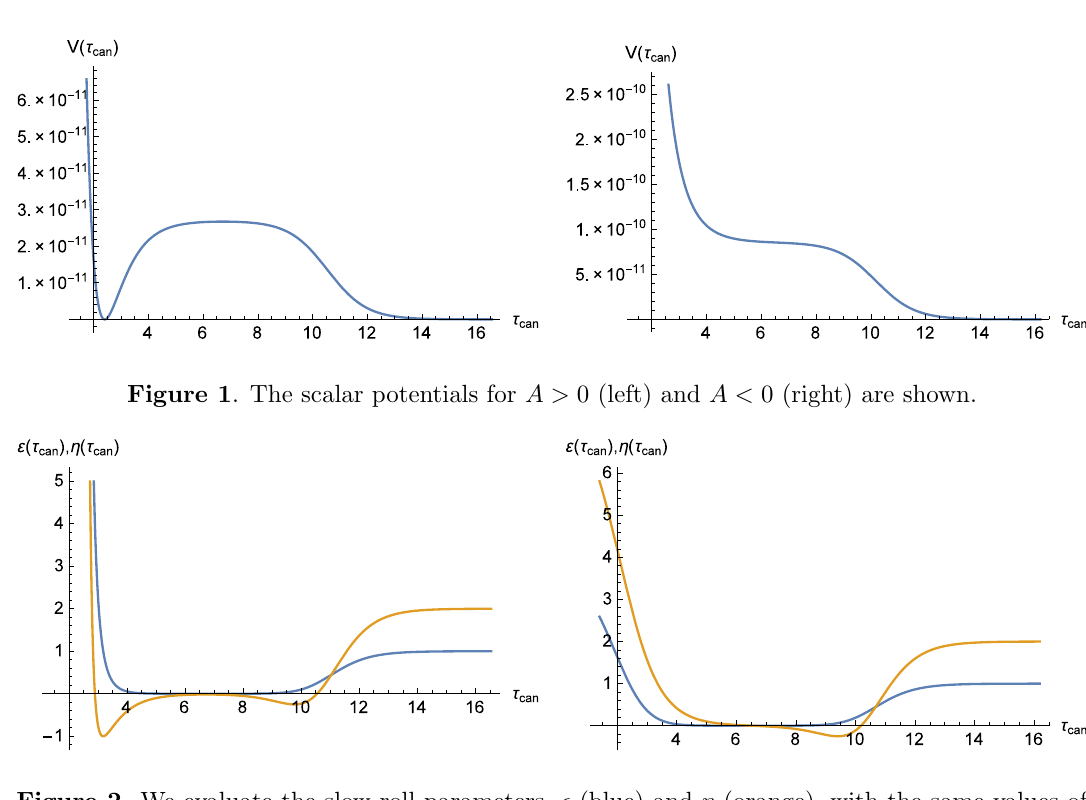
Figure 2 . We evaluate the slow roll parameters, (cid:15) (blue) and (cid:17) (orange), with the same values of input parameters as those used in (cid:12)gure